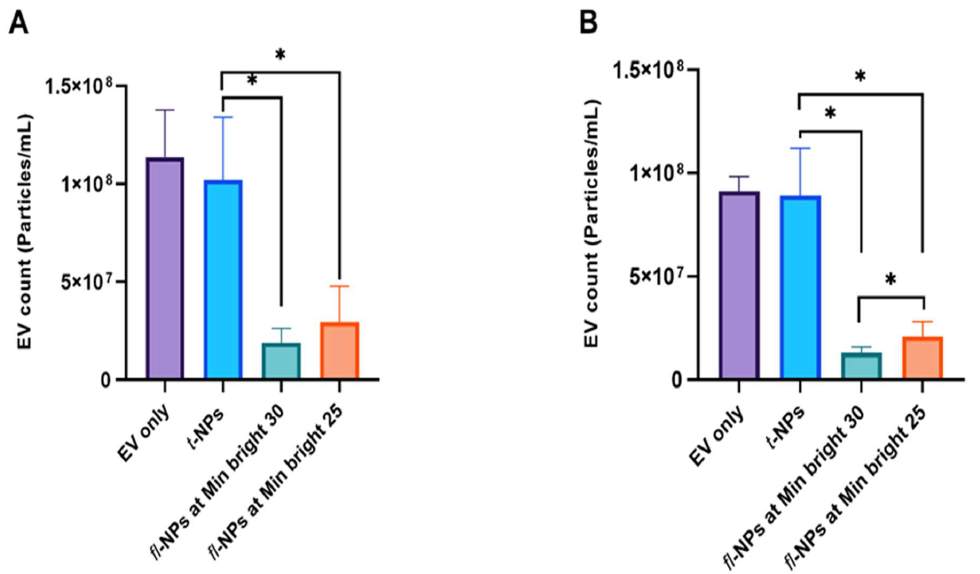
Figure 2. Concentration of total and fluorescent NPs originated from JAr and HCT 116 cells. The concentrations for EVs only control (light purple boxes), CMG-labeled fluorescent (cyanish-green and orange boxes), and total NPs (light blue boxes) of JAr ( A ) and HCT 116 EVs ( B ), measured in fluorescent and scatter modes of ZetaView ® NTA at two different minimum brightness threshold levels. The data points for fl- NPs measured at two different minimum brightness threshold levels were significantly different ( p ≤ 0.05) than t -NPs measured at the highest brightness threshold, that is, 30 and thus were marked with an asterisk (*) symbol (mean ± SD, n = 9).